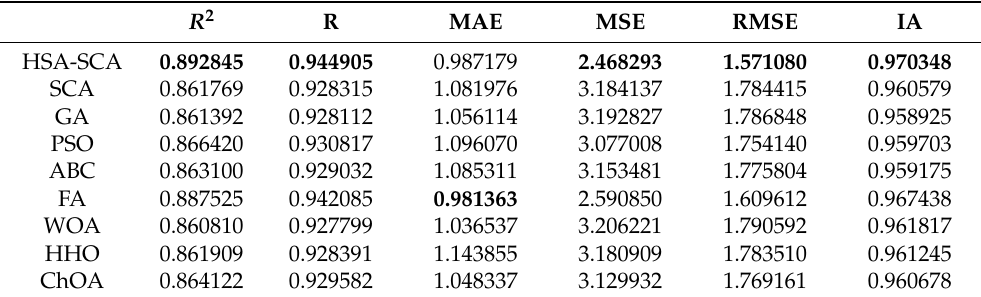
Table 2. Detailed metrics for the best individual run of the observed metaheuristics.